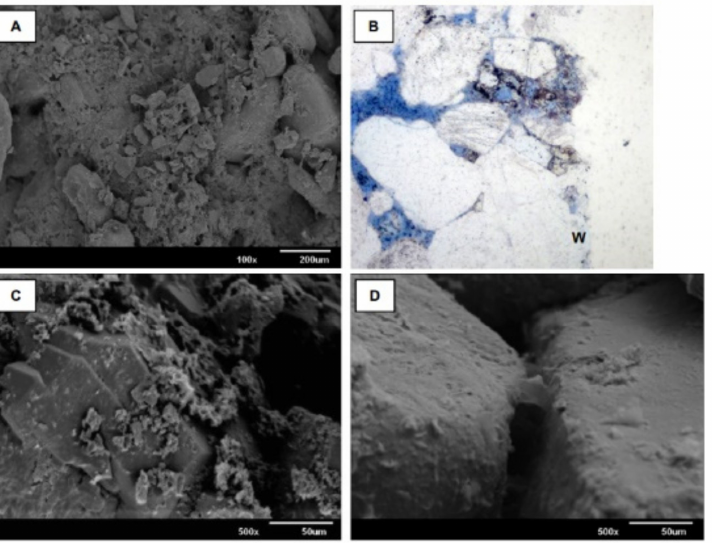
Figure 23. SEM photomicrographs of core samples from the South Morecambe gas field in the UK’s East Irish Sea after permeability testing using sodium/potassium-and sodium-based drilling fluids: ( A ) residue of encrust observed in the sample; ( B ) W indicating alterations a few mm deep into the wellbore face; ( C ) randomly emplaced encrust and filtrate a few microns deep into the rock material; ( D ) dense mineral walls indicating the presence of filtrate